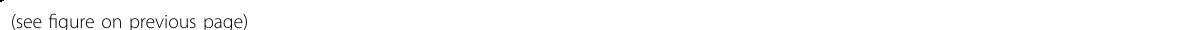
Fig. 4 Inhibition of oncogenic effects of ETS1 by EHF-SF. A, B , and C HOC313 and TSU cells infected with lentiviruses carrying control (cont.) or fl ag-tagged EHF-SF were subjected to IB analysis using the indicated antibodies ( A ). Motility assays using a Boyden chamber assay with inserts coated with type I collagen gel (upper panels) and a wound healing assay (lower panels) ( B ). Chemoresistance assay in response to the indicated concentration (conc.) of docetaxel ( C ). Each value represents the mean ± s.d. of triplicate determinations from a representative experiment. Similar results were obtained in at least three independent experiments. D and E HSC3 cells infected with either control ( n = 6) or fl ag-tagged EHF-SF ( n = 8) were injected into the periosteal region of the parietal bone in mice. Five weeks later, mice were sacri fi ced, and tumor volume was measured ( E ). After decalci fi cation, specimens were prepared. Typical histology in hematoxylin and eosin staining are shown. B bone, T tumor. ( F, G, H, I, and J ) MDA-MB-231-Luc cells infected with either control or EHF-SF were visualized by phase-contrast microscopy ( F ), and subjected to IB analysis ( G ) and motility assays ( H ). The cells were injected into the left ventricle of the heart, followed by imaging analysis ( I ) and quanti fi cation ( J ) at 35 days (5 weeks). p values were determined by Student ’ s t -test. * p < 0.01, ** p < 0.03. α -tubulin was used as a loading control ( A and G